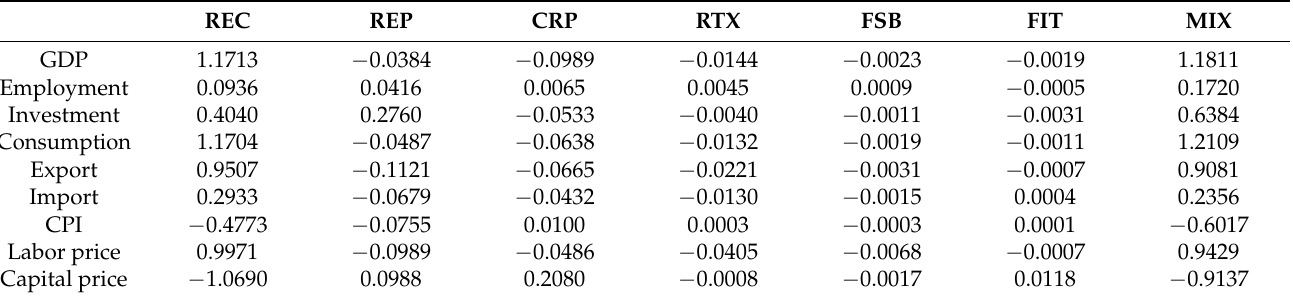
Table 1. The accumulative impacts of renewable energy policies on macroeconomic indicators in 2020–2060 relative to the baseline scenario